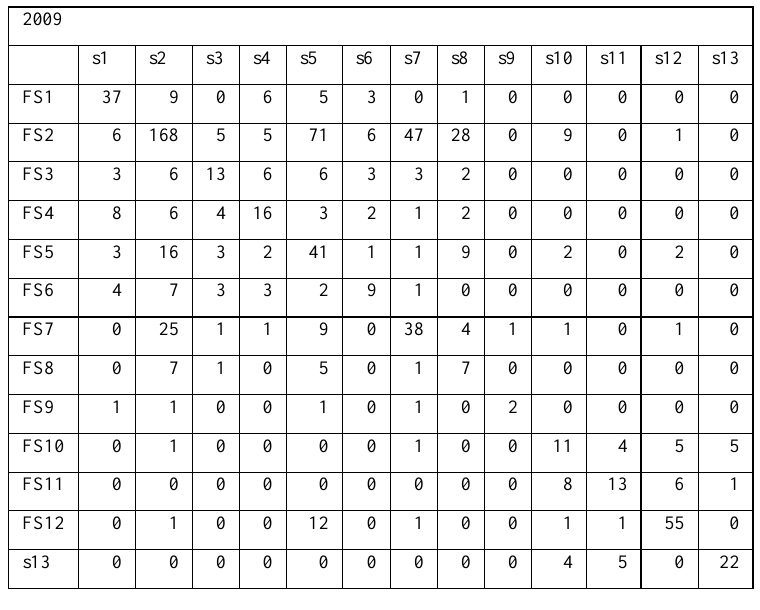
Table A1.2. Data used in the compartmentalization analysis for number of fishers in primary fishing strategies (FSx) and switching to temporary fishing strategies (sx) in 2009. Self-loops were removed. See Table S1a caption for how the data was used in network